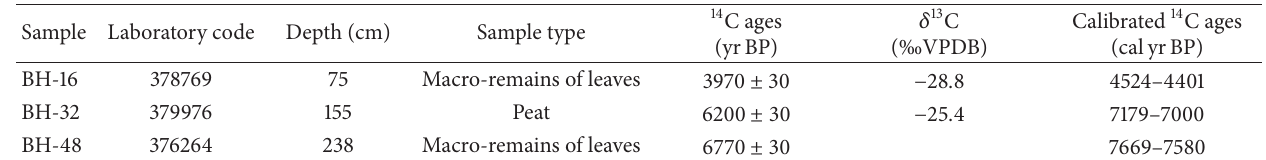
Table 1: AMS 14 C dating results from the Beihong Section.